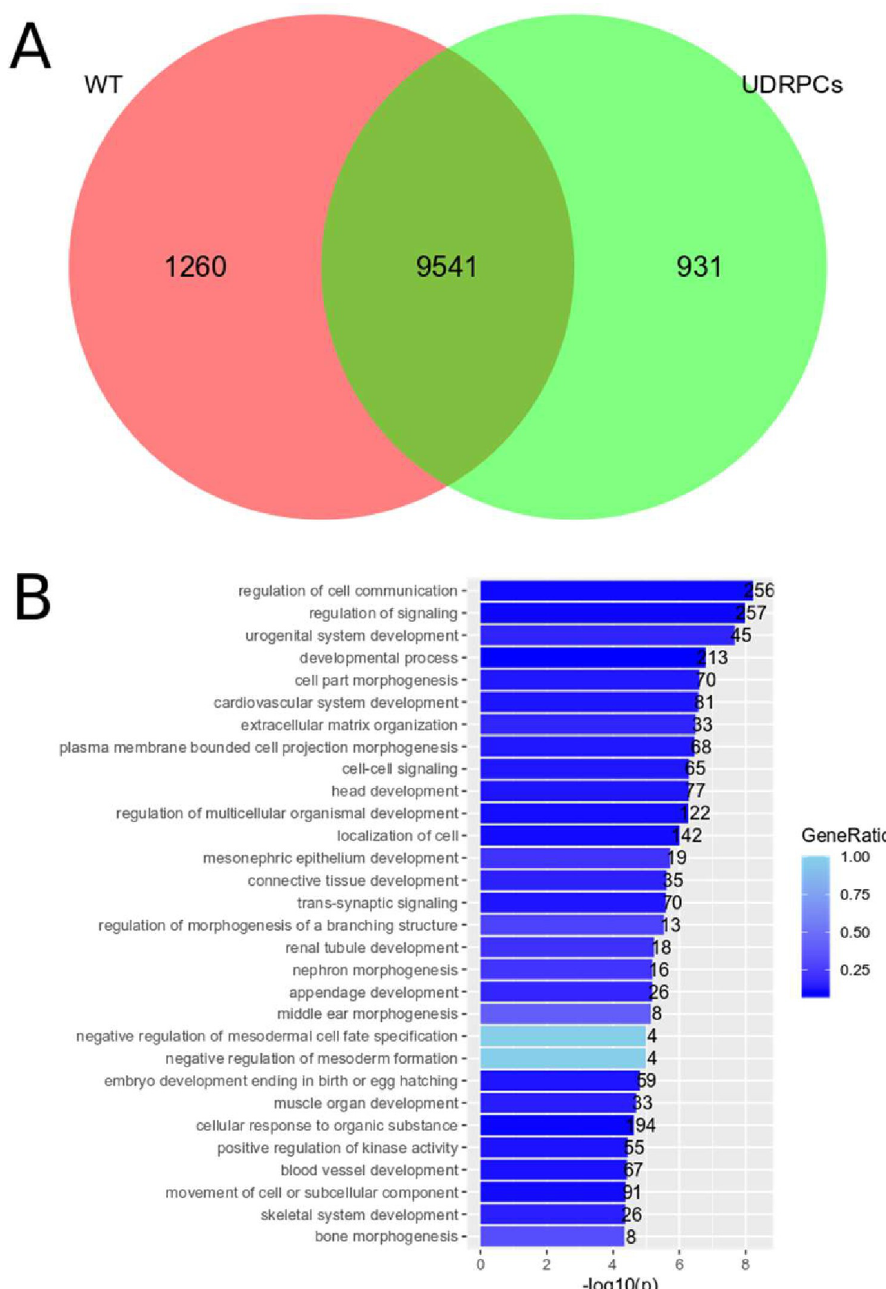
Fig 13. Comparison of Wilms cell lines with UdRPC and analysis of the Go BP-terms of the common gene set. A) The Venn diagram shows the overlap between genes expressed in Wilms tumor cells (red) and UdRPC (green) and the exclusively expressed genes. B) the 30 top Go BP-terms of the 1260 genes exclusively expressed in Wilms cells.